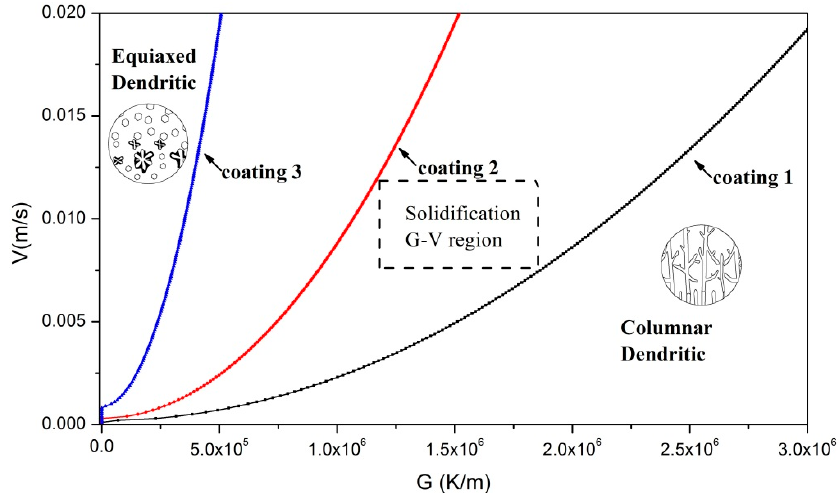
Figure 10. Plot of solidification front velocity V against Temperature gradient G for Ni-Cr-Si alloys, N 0 = 2 × 10 15 , ϕ 1 = 0.9, ϕ 2 = 0.05, ϕ 3 = 0.01. = 2 × 10 15 , ϕ 1 = 0.9, ϕ 2 = 0.05, ϕ 3 =